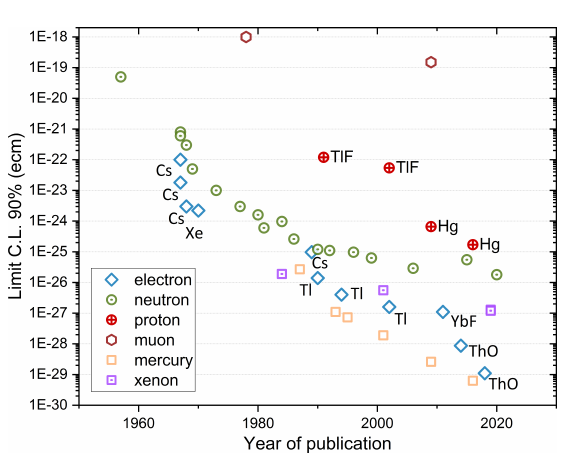
Figure 2. Plot of the history of upper EDM limits (CL 90%) as function of the year of